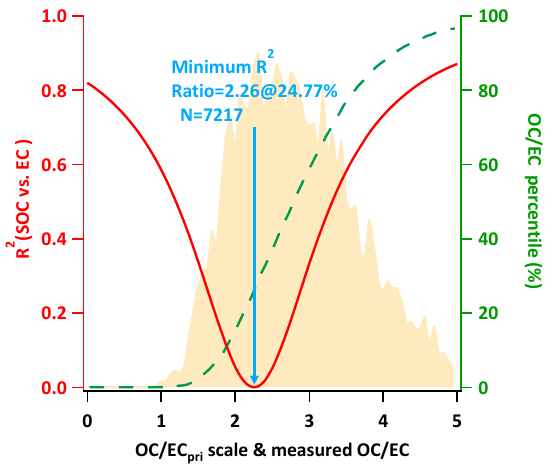
Figure 1. Illustration of the minimum R squared method (MRS) to determine OC / EC pri using 1year of hourly OC and EC measure- ments at a suburban site in the Pearl River Delta, China. The red curve shows the correlation coefficient ( R 2 ) between SOC and EC as a function of assumed OC / EC pri . The shaded area in tan repre- sents the frequency distribution of the OC / EC ratio for the entire OC and EC data set. The green dashed curve is the cumulative fre- quency curve of OC / EC